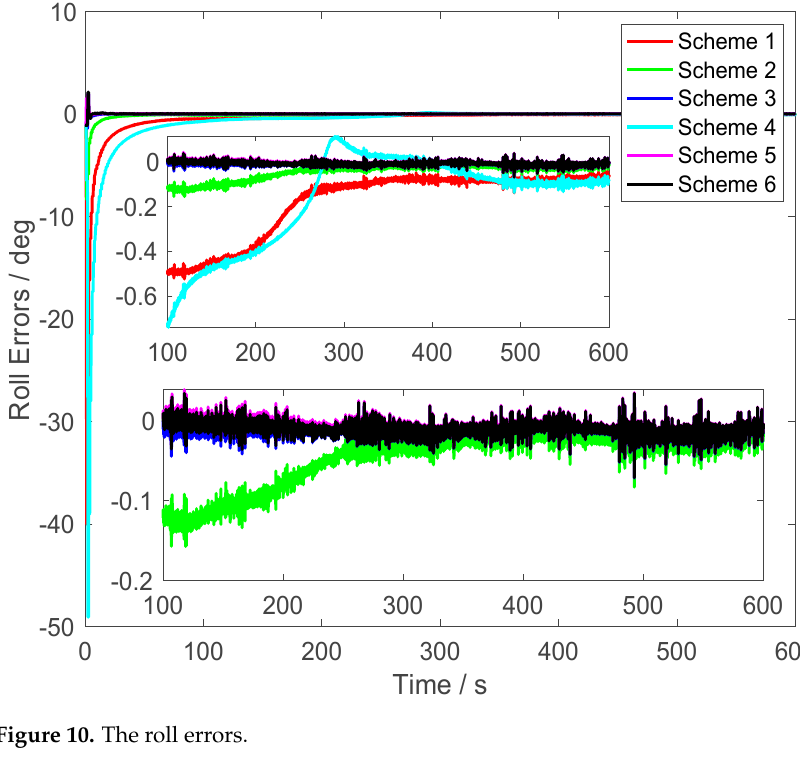
Figure 10. The roll errors.